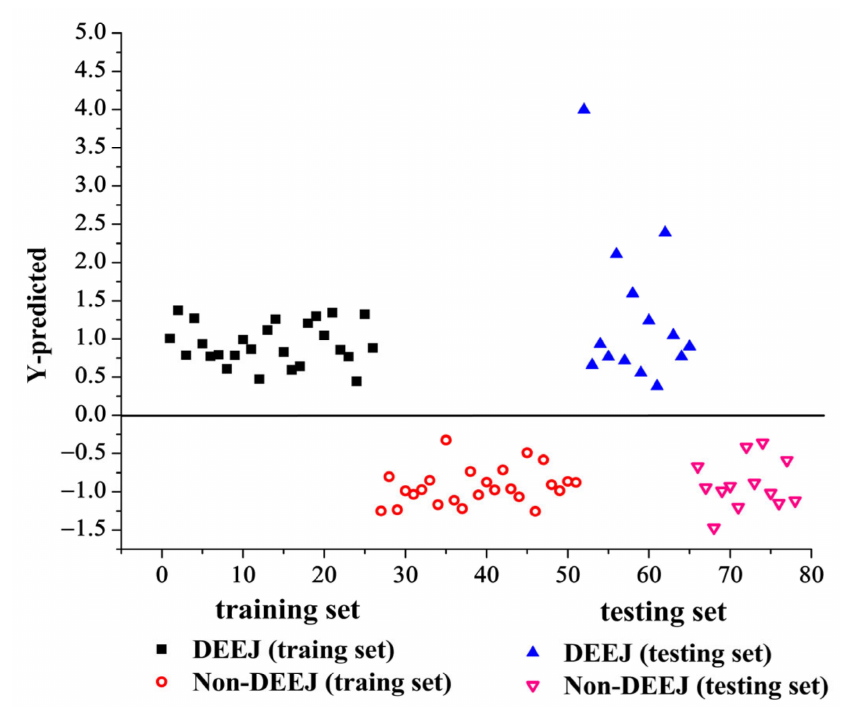
Figure 5. The PLS-DA model of NIR spectra pretreated by multiplicative scatter correction